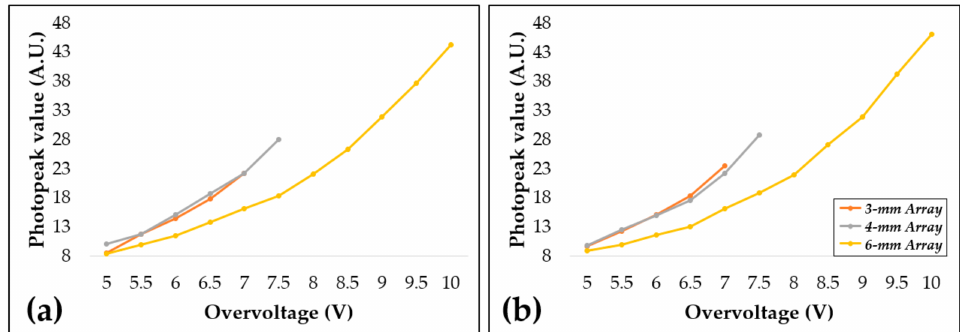
Figure 7. Photopeak value as a function of the overvoltage: ( a ) With and ( b ) without application of the analog high-pass filter.